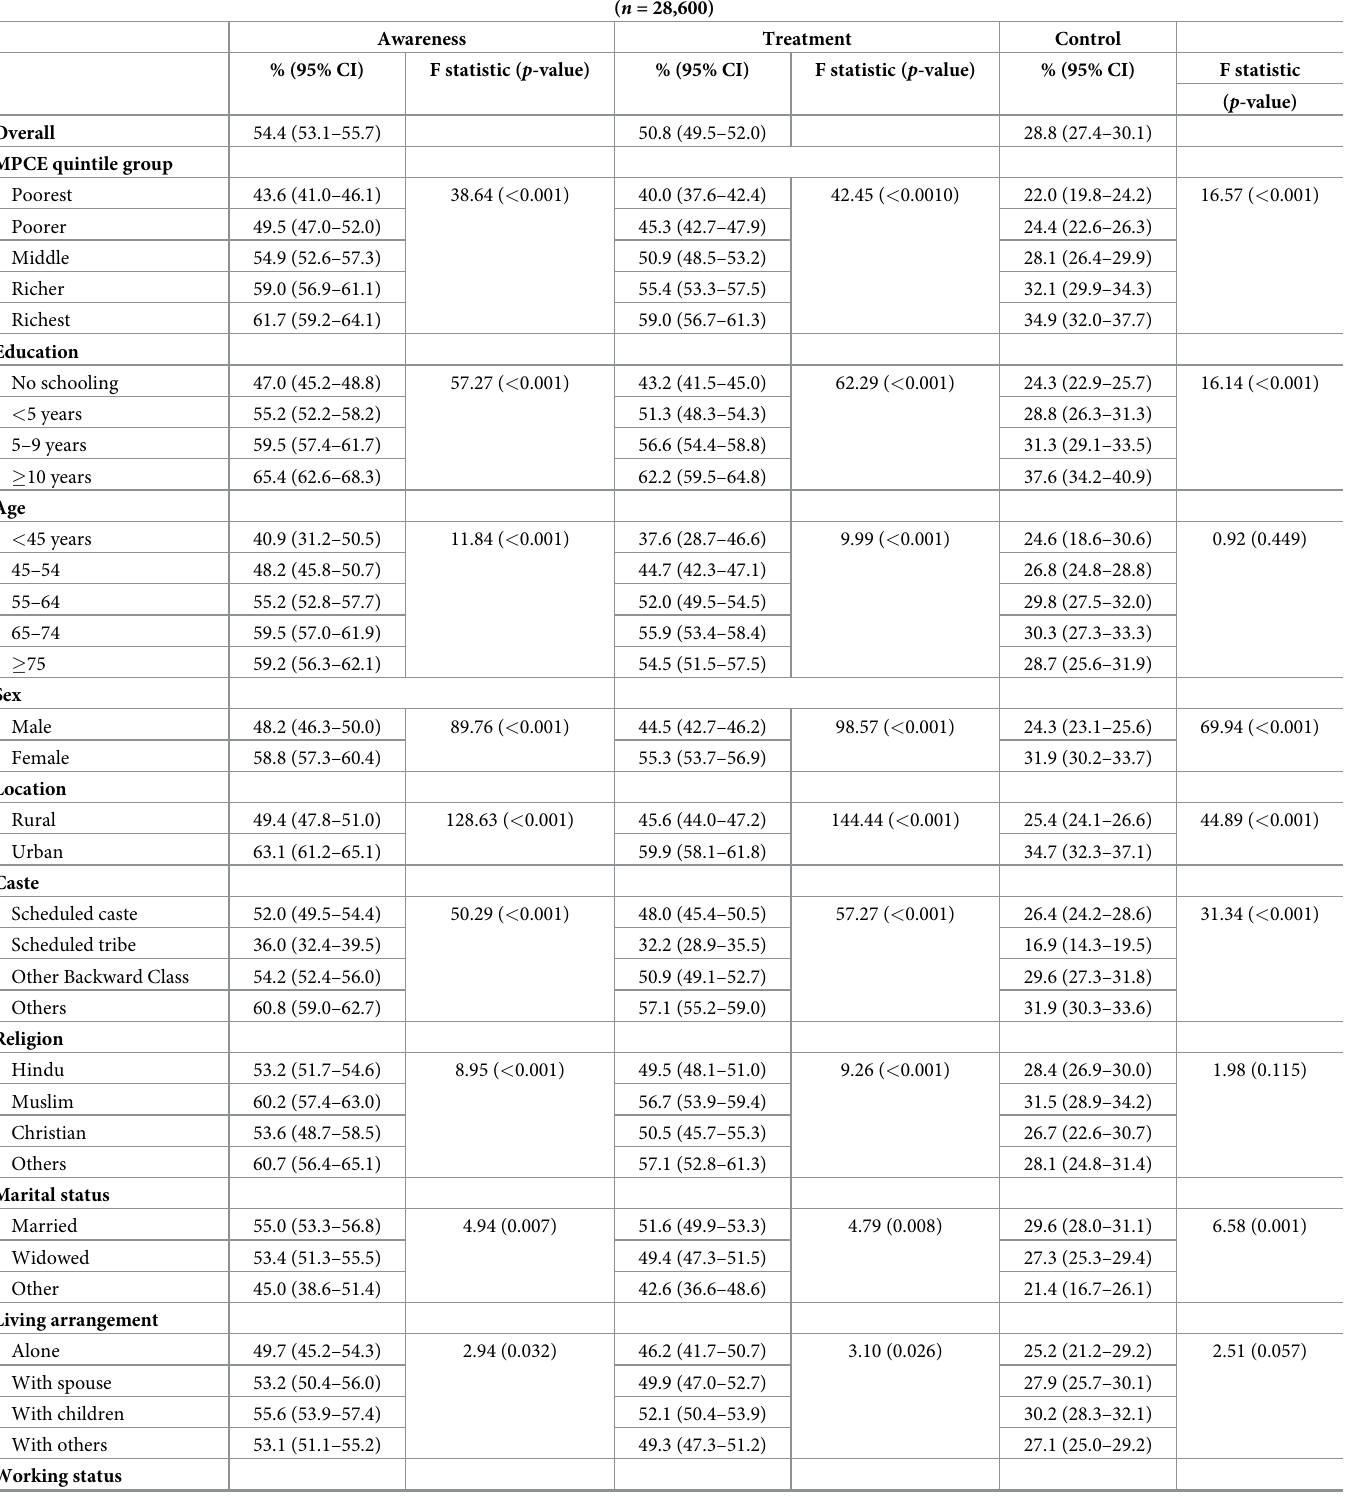
Table 3. Adjusted percent aware, treated, and controlled among those with hypertension, adults aged 45 years and over and their